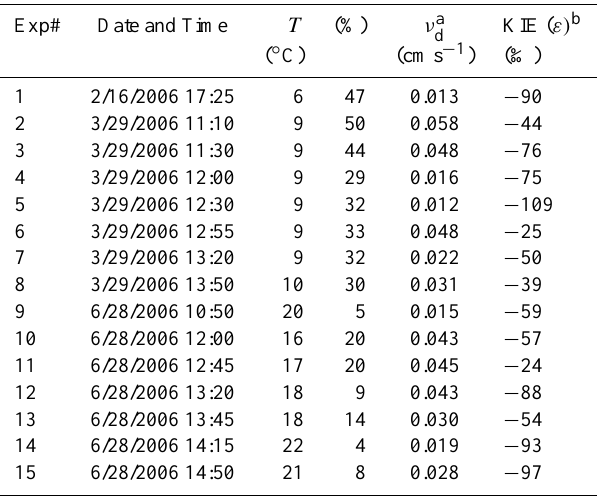
Table 1. Select data from field experiments including experiment number, soil temperature, soil moisture content, deposition velocity ( ν d ) , and the calculated kinetic isotope effect ( ε)